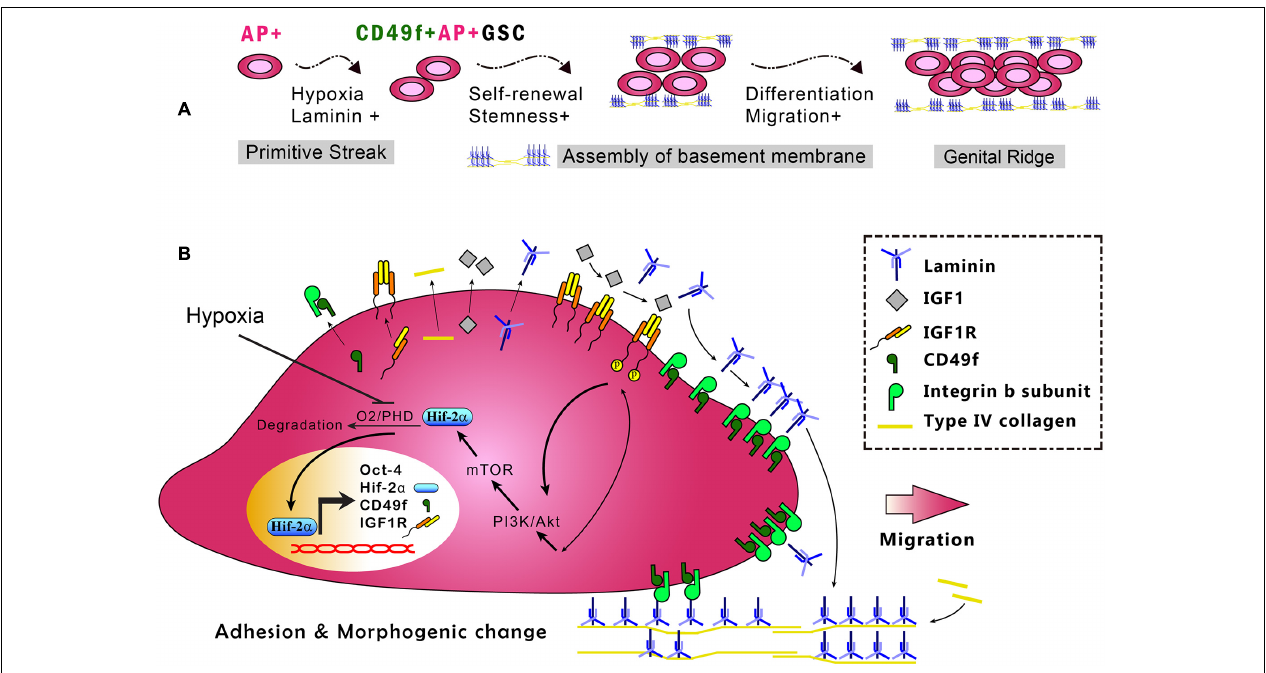
FIGURE 6 | In vitro model of the CD49f/IGF1R-Hif-2 α regulatory circuit in CD49f + AP + GSCs. (A) Depiction of the stages in early germ cell development. (B) In vitro model of CD49f/IGF1R-Hif-2 α signaling circuit in mouse CD49f + AP + GSCs under hypoxic conditions. AP, alkaline phosphatase; HIF, hypoxia-inducible protein; IGF-1, insulin-like growth factor-1; IGF-1R, insulin-like growth factor-1 receptor; PHD, prolyl hydroxylases. Notably, the laminin lattice network can be assembled on the cell surface through integrin and in turn be incorporated into the underlying type IV collagen network, thereby forming the basement membrane (Hohenester and Yurchenco, 2013; Yurchenco,